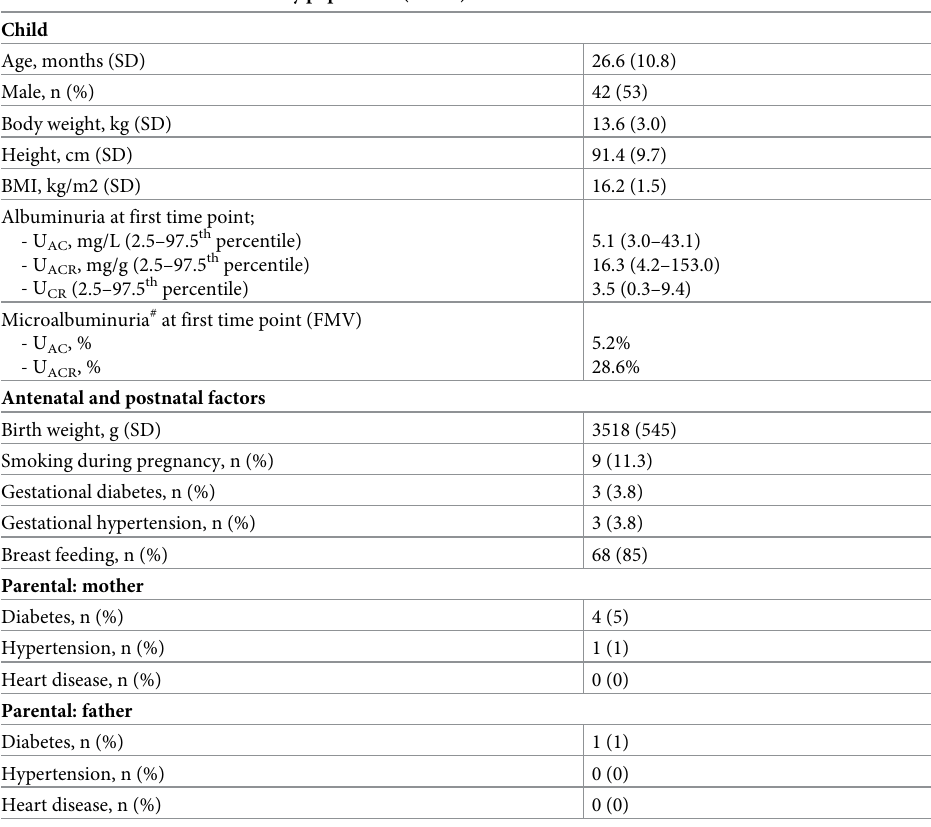
Table 1. Characteristics of the study population (n = 80).